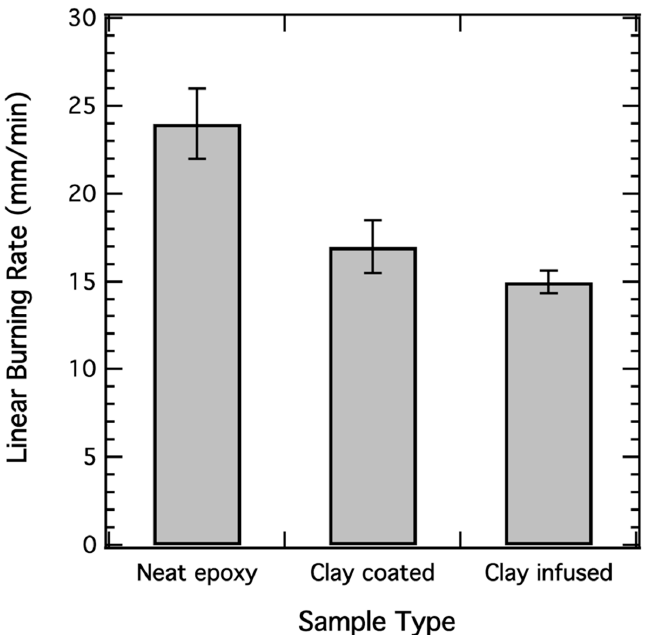
Figure 7. Linear burning rate of neat and clay carpet composites. The error bar shows ± standard deviation of eleven